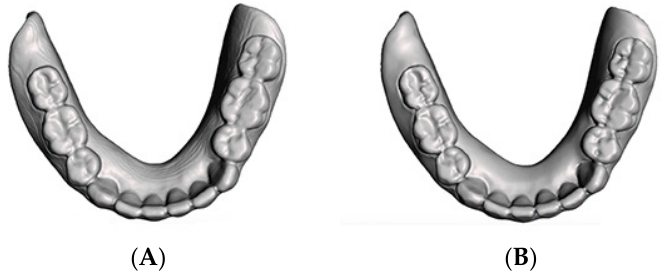
Figure 2. Occlusal view of the digital denture. ( A ) Digital denture produced by the CBCT scan and convert protocol. ( B ) Digital denture produced by the optical scan and merge technique.